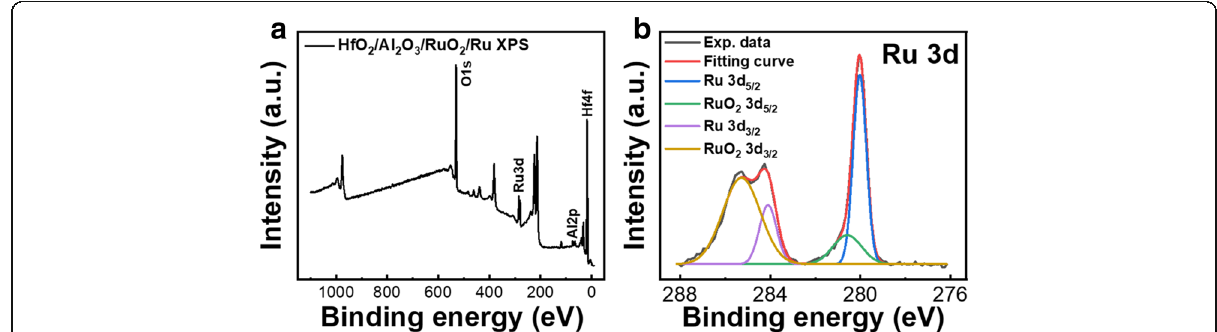
Fig. 6 XPS spectra of a Ru/AlO y /HfO x thin film and b Ru 3d core level. The RuO 2 thin film between Ru and AlO y forms during ALD process